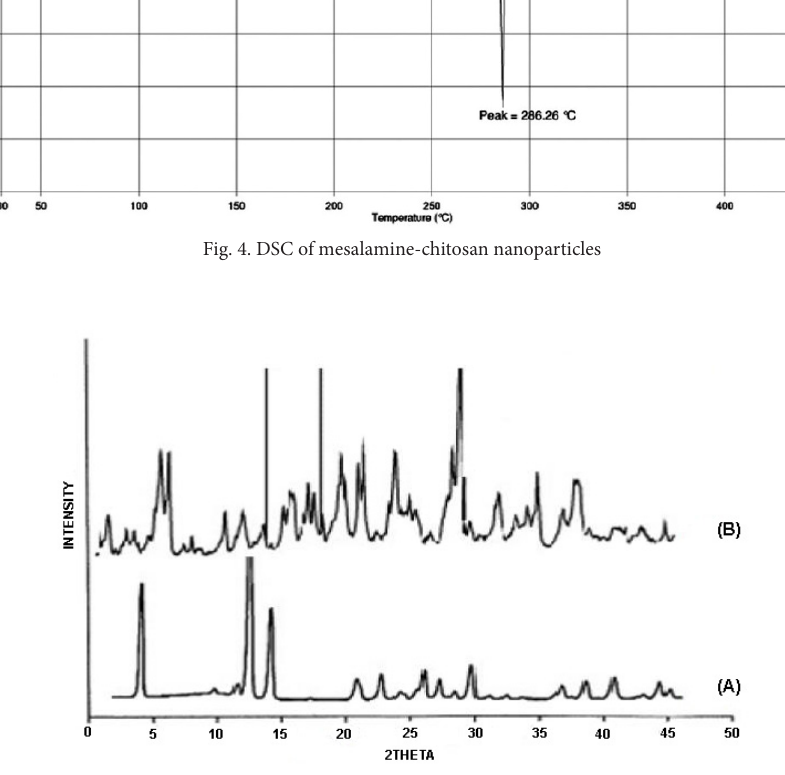
Fig. 5. XRD of (A) mesalamine, (B) mesalamin-chitosan nanoparticles